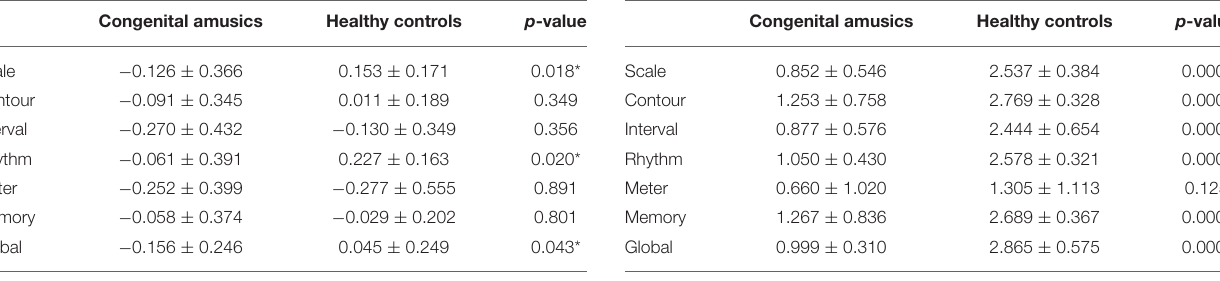
TABLE 4 | c value measured by SDT in the congenital amusia group and healthy control group. Congenital amusics Healthy controls p -value